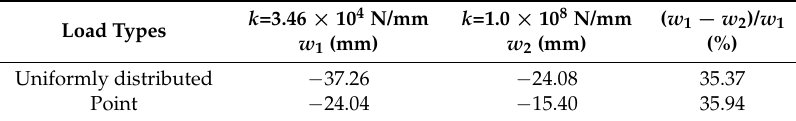
Table 2. Comparison of maximum deflection between partial connection and full connection for the composite